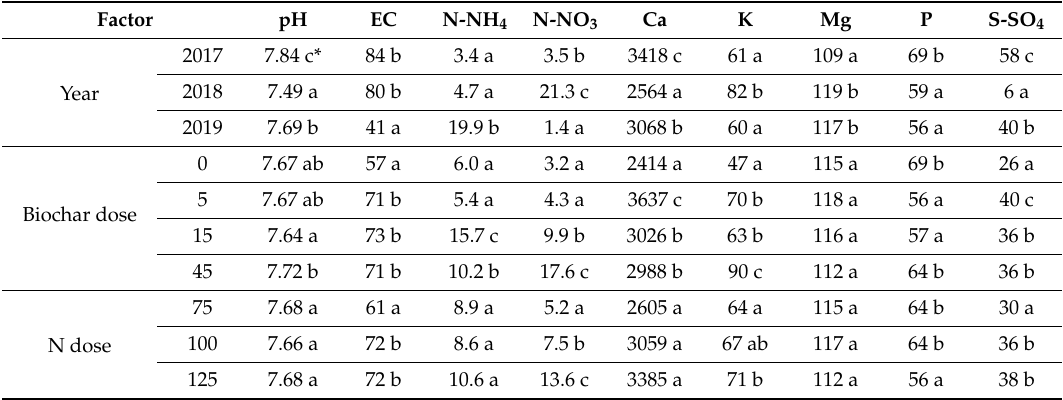
Table 5. Soil reaction (pH H2O ), salt concentration (EC µ S cm − 1 ), and the contents of macronutrients (mg dm − 3 ) in soil fertilized with di ff erent doses of nitrogen (kg N ha − 1 ) at di ff erent levels of enrichment of soil with biochar (t ha − 1 ) in